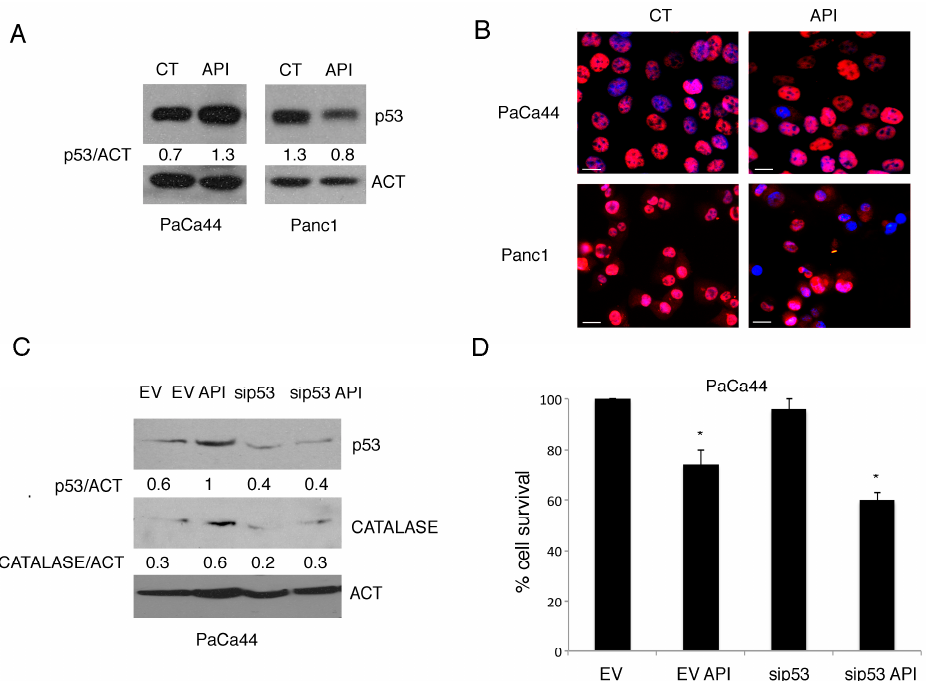
Figure 3. Mutant p53 expression correlates with NRF2 activation. ( A ) mutp53 expression in Apigenin- treated or untreated PaCa44 and Panc1 cells evaluated by western blot analysis. Actin was used as loading control. A representative experiment out of three is shown and the densitometric analysis of the ratio of p53/actin is reported; ( B ) mutp53 expression in Apigenin-treated or untreated PaCa44 and Panc1 cells as evaluated by IFA after 24 h of treatment; Scale bar: 10 mm. ( C ) mutp53 and catalase expression in p53- or scramble-silenced PaCa44 cells treated or untreated with Apigenin was evaluated by western blot analysis. Actin was used as loading control. A representative experiment out of three is shown and the densitometric analysis of the ratio of p53/actin and catalase/actin is reported; ( D ) Viability of p53- or scramble-silenced PaCa44 cells treated or untreated with Apigenin was evaluated by trypan blue exclusion assay. Mean plus SD of three independent experiments is reported. * p -value < 0.05. Control (CT); Apigenin (Api); actin (ACT); empty vector (EV); p53 siRNA (sip53).